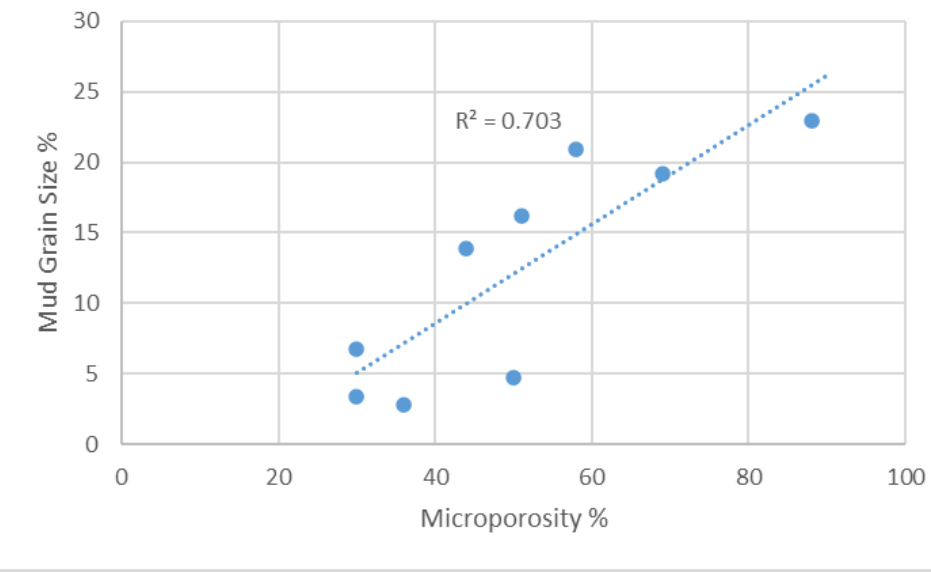
Figure 25. Thorium/potassium cross-plot showing the different classes of permeability and clay minerals type associated with them (modified after [24]). From the Th/K cross-plot, it is evident that chlorite and montmorillonite have pre- served permeability against porosity, reducing diagenetic processes such as pore filling, quartz cement, and the overgrowth of quartz. However, kaolinite and mixed-layer clay can be responsible for reducing the permeability. Integrating the sieve analysis with the